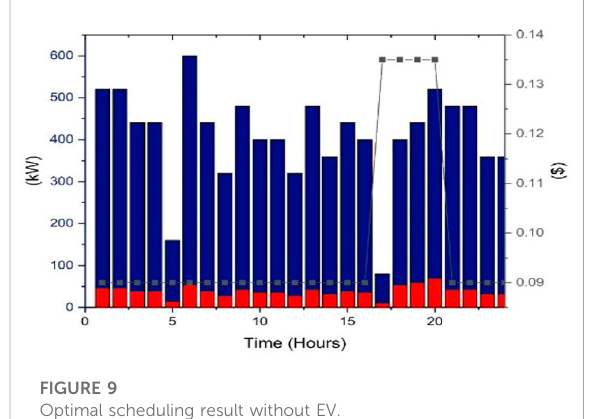
FIGURE 11 Cost comparison